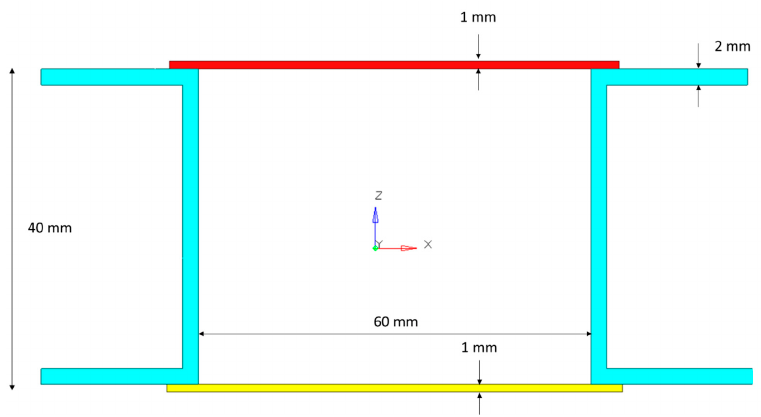
Figure 4. ( a ) Upper and lower plates visualized as a laminate stack; ( b ) normal direction for upper and lower plates shell elements.